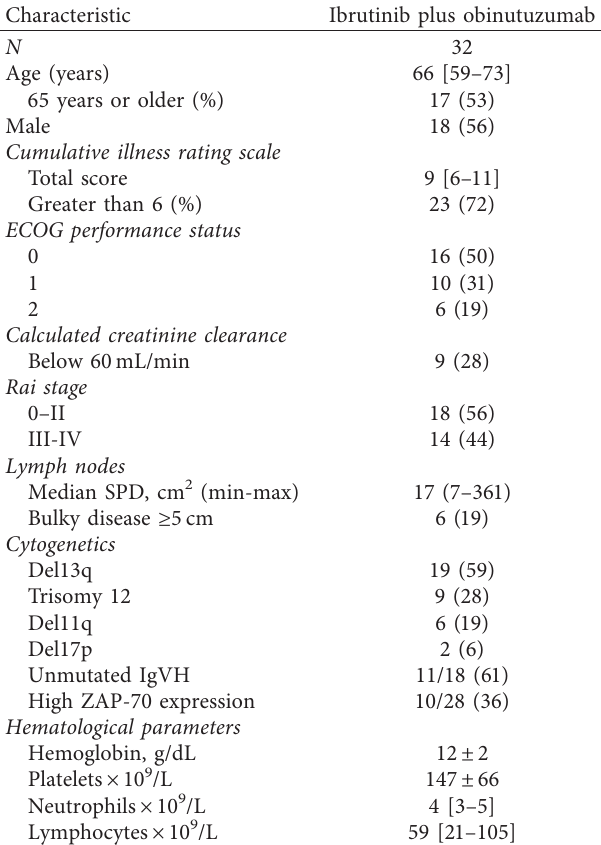
Table 1: Descriptive characteristics of the study population, means ± SD, median [IQR], or N